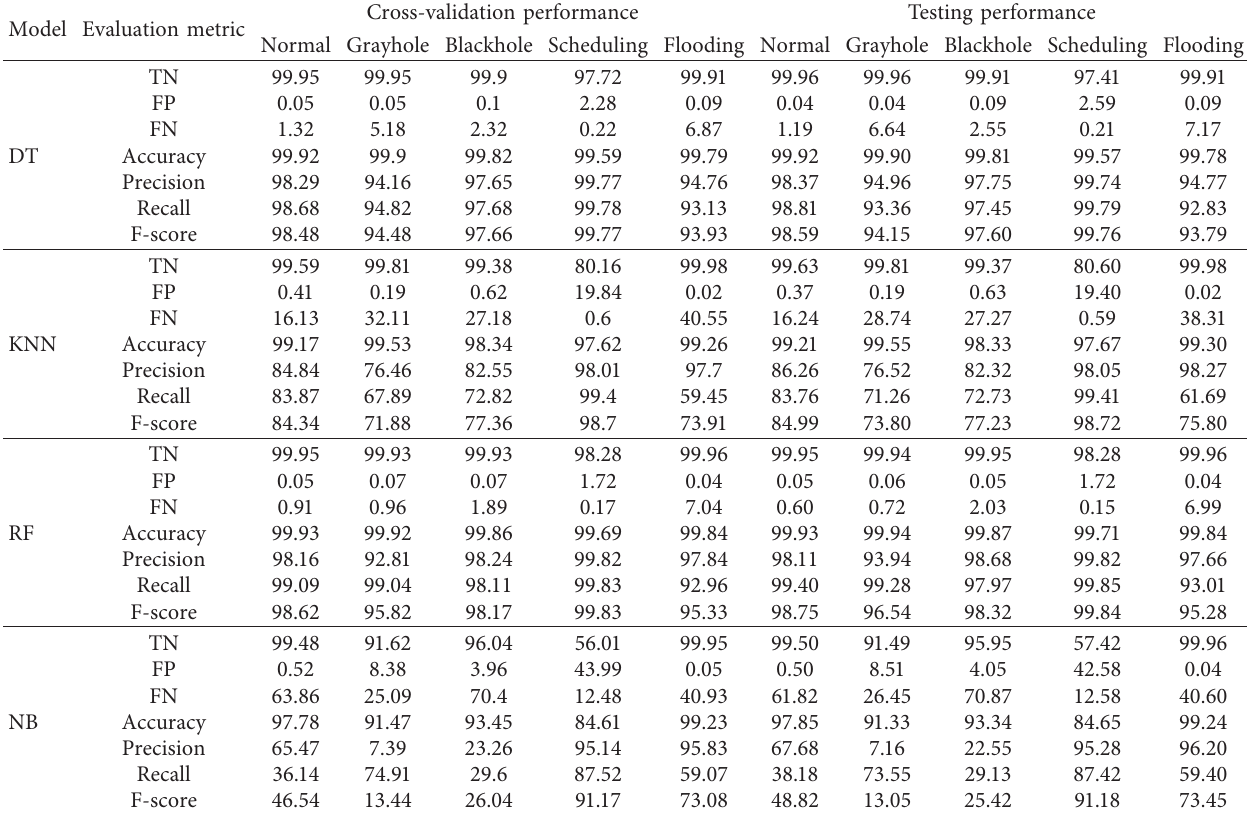
Table 11: The performance of machine learning for WSN dataset using selected features. Model Evaluation